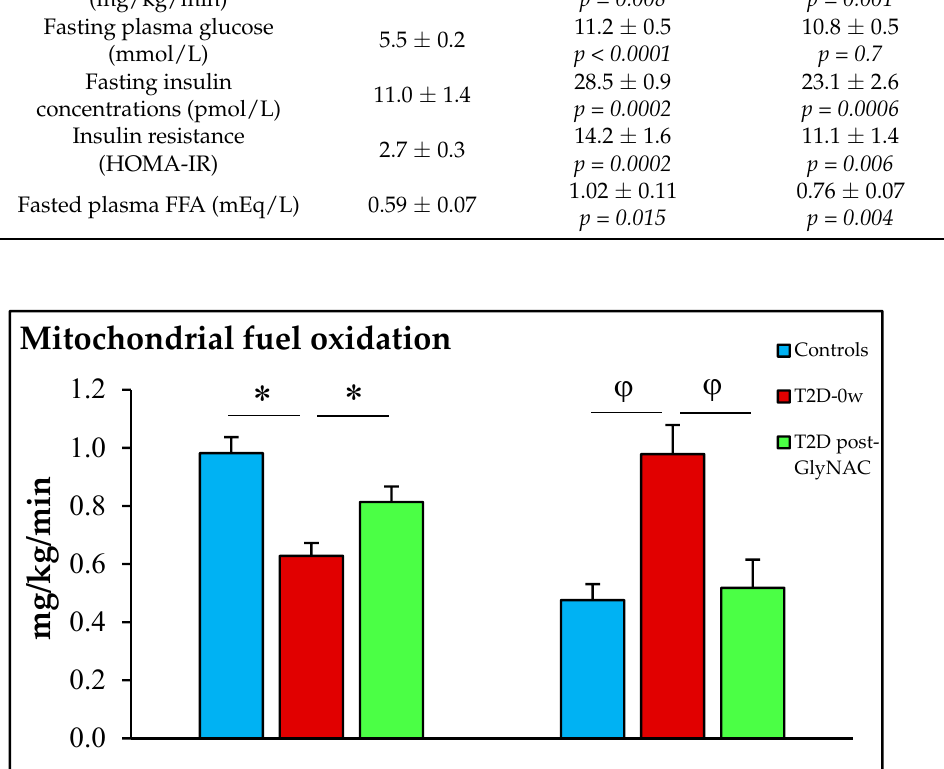
0.0006), FFA by 25% ( p = 0.004), and decreased IR by 22% ( p = 0.006), but there were no